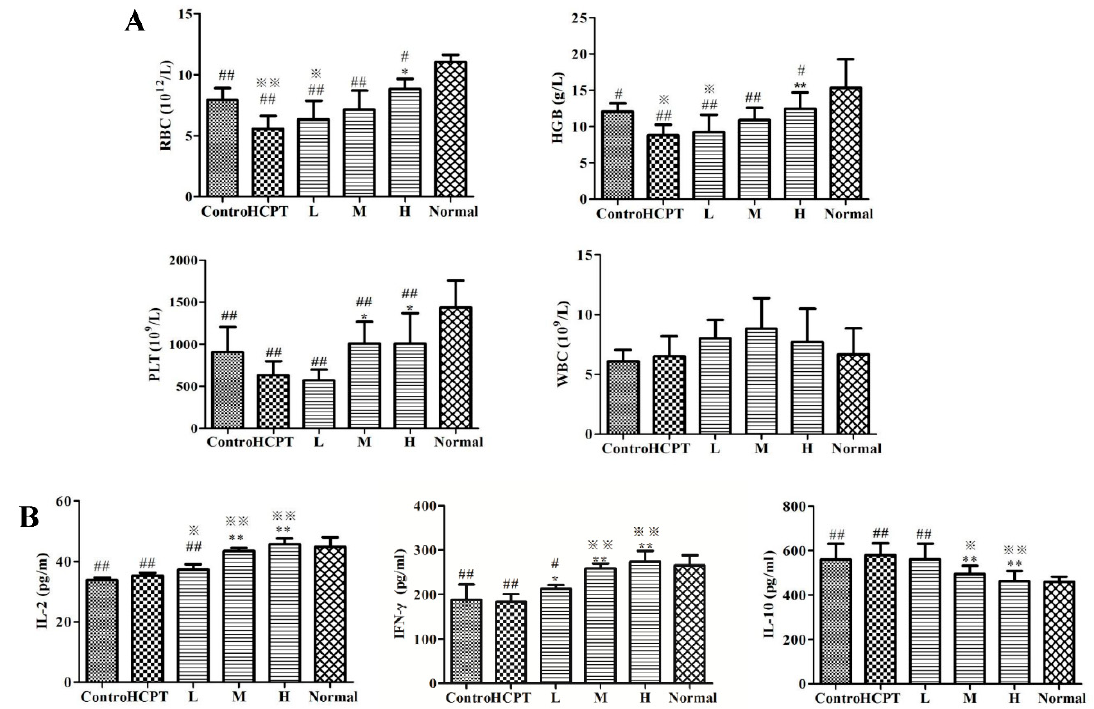
Figure 5. Combination of JGGC and HCPT on the routine blood (WBCs, RBCs, HGB, and PLTs) ( A ) and immune cytokine (IL-2, IL-10, and IFN- γ ) ( B ) of Lewis lung carcinoma mice. Data are shown as mean ± SD, n = 10. # p < 0.05, ## p < 0.01 vs. normal; ※ p < 0.05, ※※ p < 0.01 vs. control; * p < 0.05, ** p < 0.01, vs. HCPT.